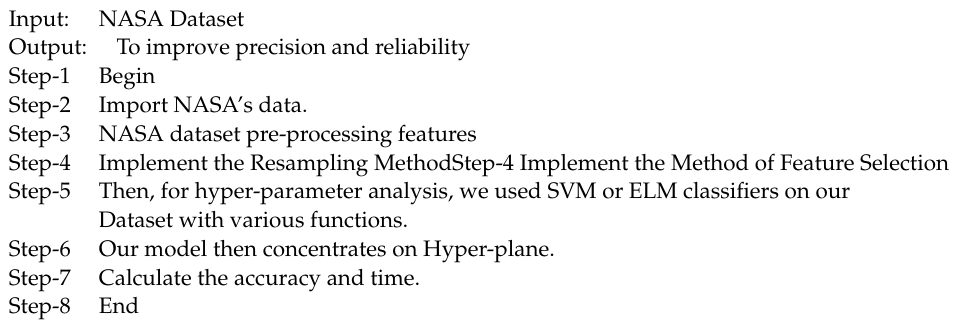
Algorithm 1 Calculating the accuracy and